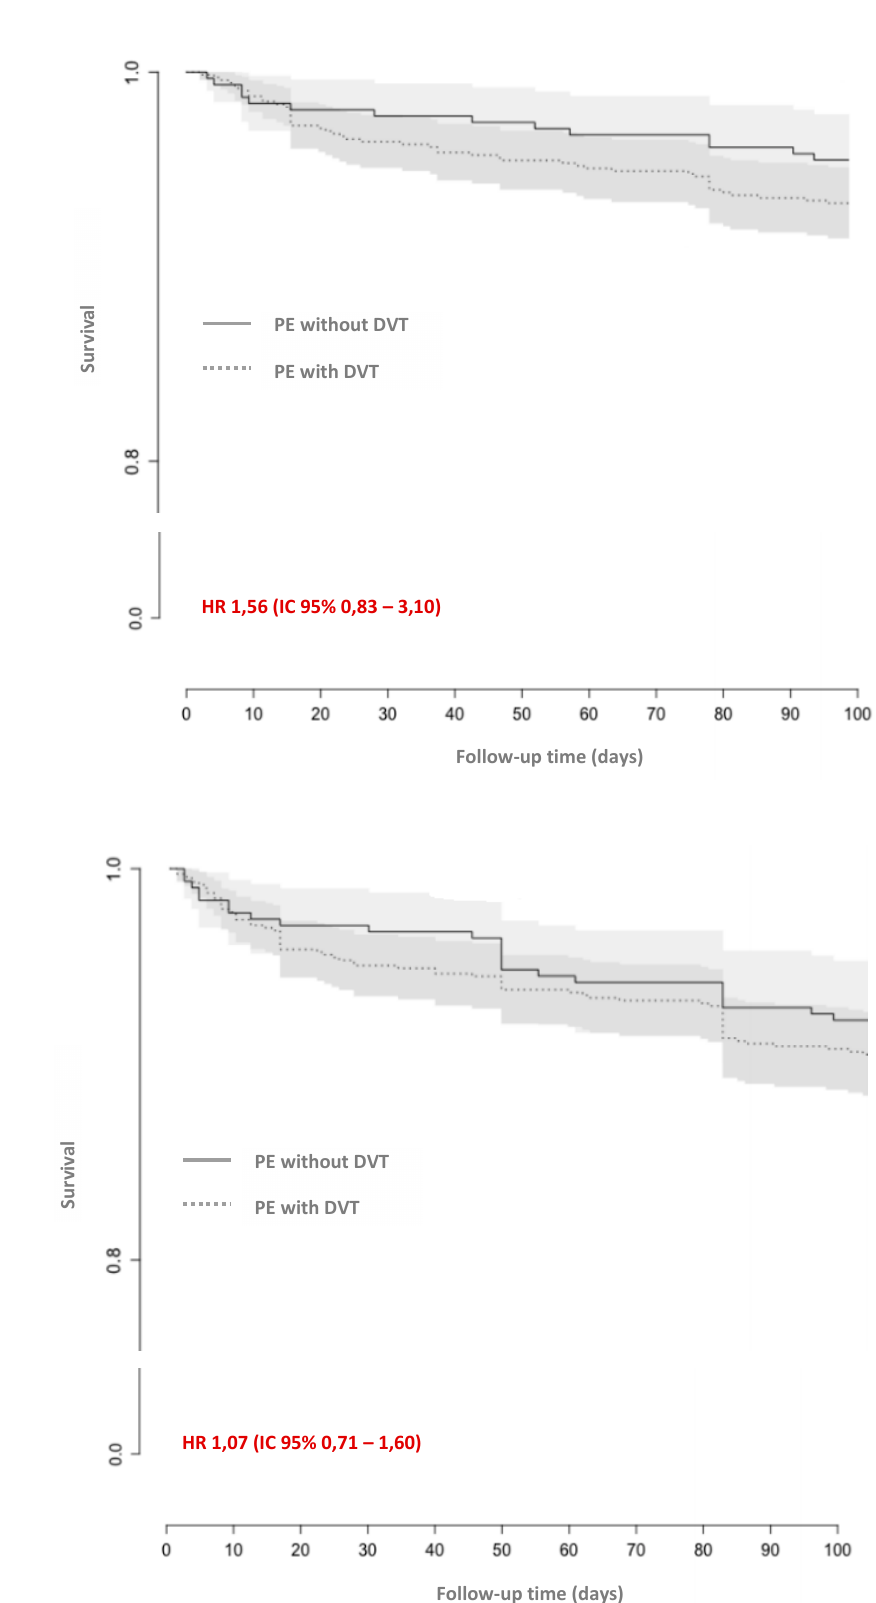
Figure 3. Kaplan–Meier curves of ( A ) all-cause mortality, ( B ) the composite of venous thromboembolism recurrence and all-cause mortality, ( C ) the composite of major and non-major clinically relevant bleeding, venous thromboembolism recurrence, and all-cause death. CI: confidence interval; HR: hazard ratio; DVT: deep vein thrombosis; PE: pulmonary